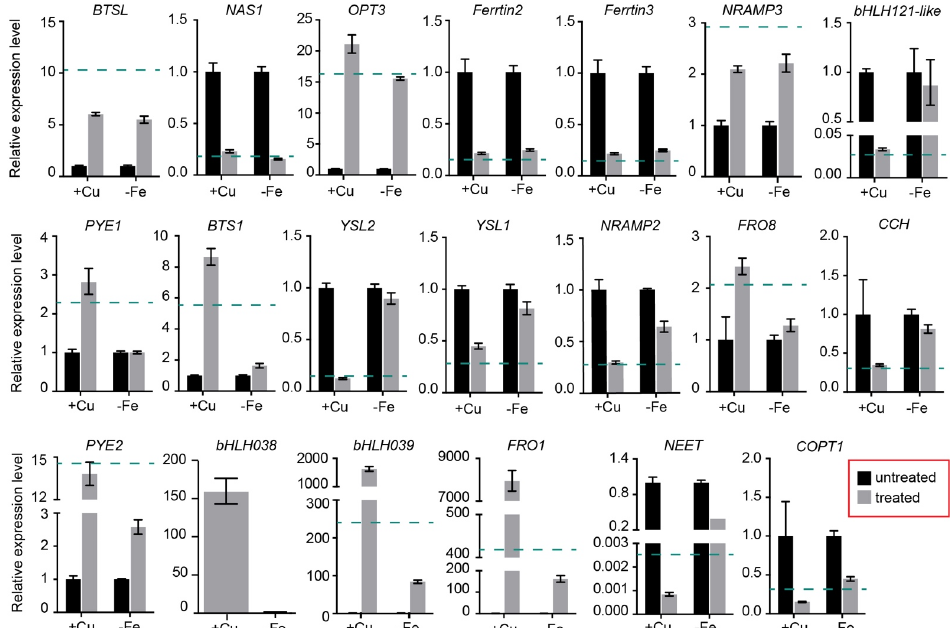
Figure 7. The relative expression level of genes involved in Fe and Cu homeostasis in petunia petals under Fe deficiency or excess Cu. Bars indicate the relative expression level determined by qRT-PCR in petunia petals exposed to 40 μ M Cu (+Cu) or 0 μ M Fe (-Fe). EF1 α as the reference gene. Values (mean ± SD, n = 3) are normalized to the gene expression level in untreated petals (set as 1). Since bHLH038 was barely expressed in untreated petals (Cq value > 35), we used the relative expression value of -Fe as 1. The green dash line indicates the fold change value of genes in petunia stage 7 petal transcriptome.